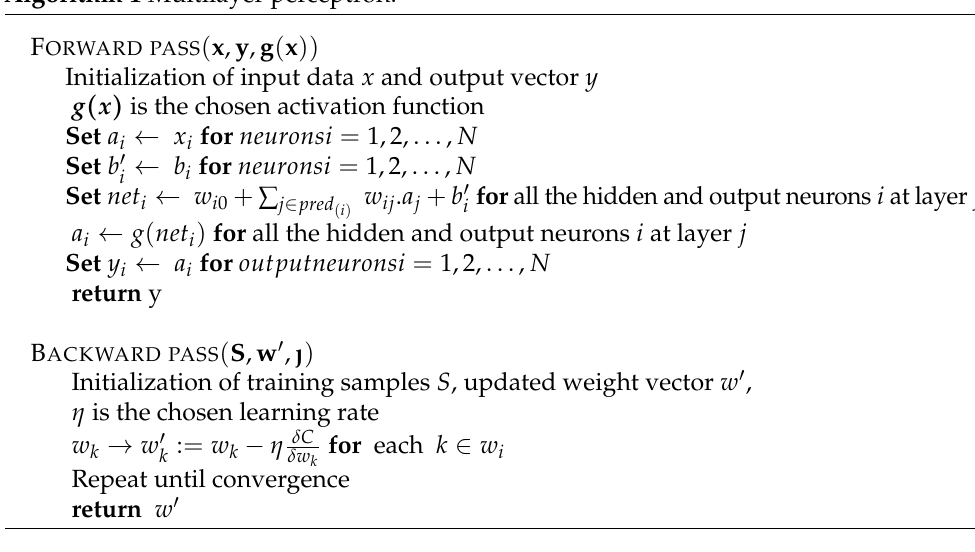
Algorithm 1 Multilayer